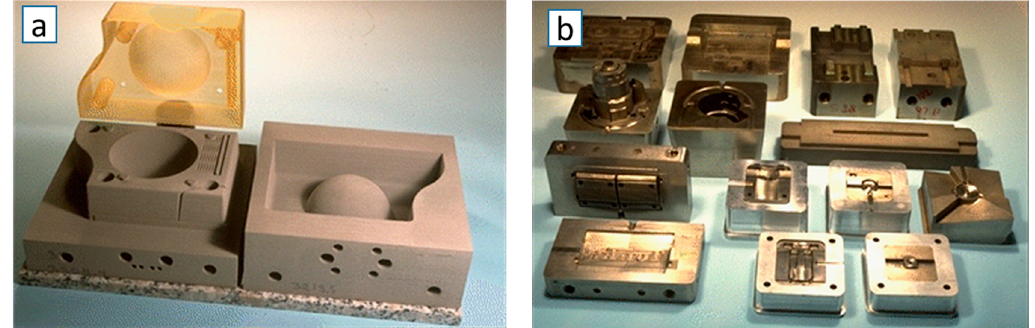
Figure 4. ( a ) Injection molding tools and molded part, ( b ) Finished metal tools manufactured by binder jetting (BJ) 3D printing [33].